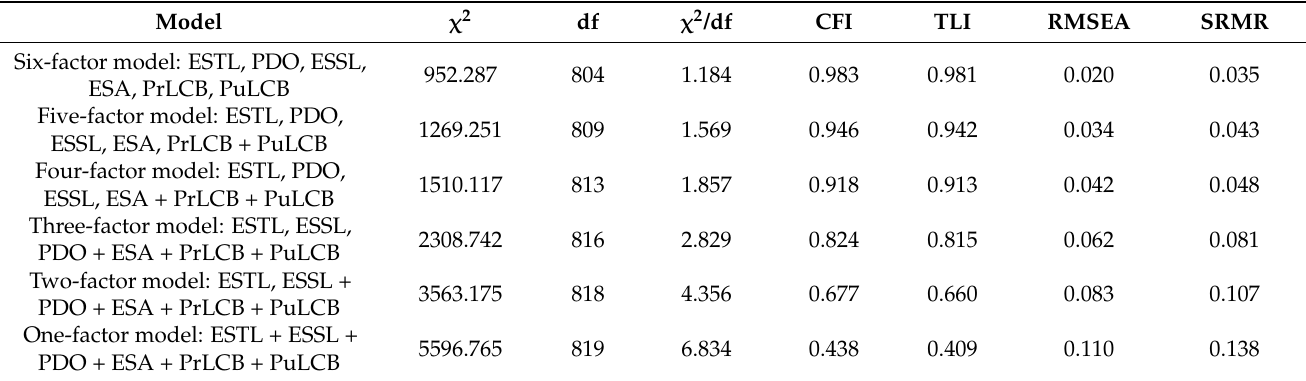
Table 1. Confirmatory factor analysis.